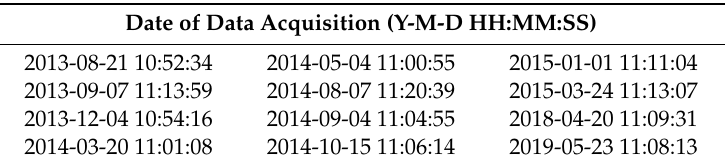
Table 2. Acquisition date of GF-1 WFV1 data used in this